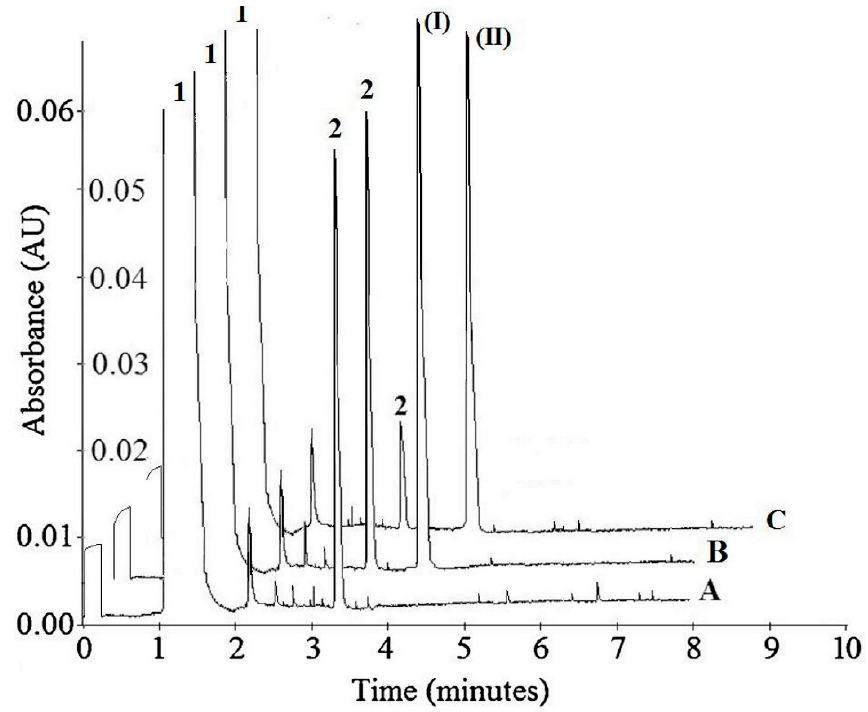
Figure 2. Representative electrophoregrams of: (A) 1.44 mM of p-nitrophenyl phosphate (PN-TE) (1) and 0.018 mM of the reaction product p-nitrophenol (PN-OL) (2) in 2 mL of incubation sample; (B) 1.44 mM of PN-TE (1) and 0.018 mM of the reaction product PN-OL (2) in the presence of 0.05 mM of ( I ) in 2 mL of incubation sample; and (C) 1.44 mM of PN-TE (1) and 0.009 mM of the reaction product PN-OL (2) in the presence of 0.05 mM of ( II ) in 2 mL of incubation sample.